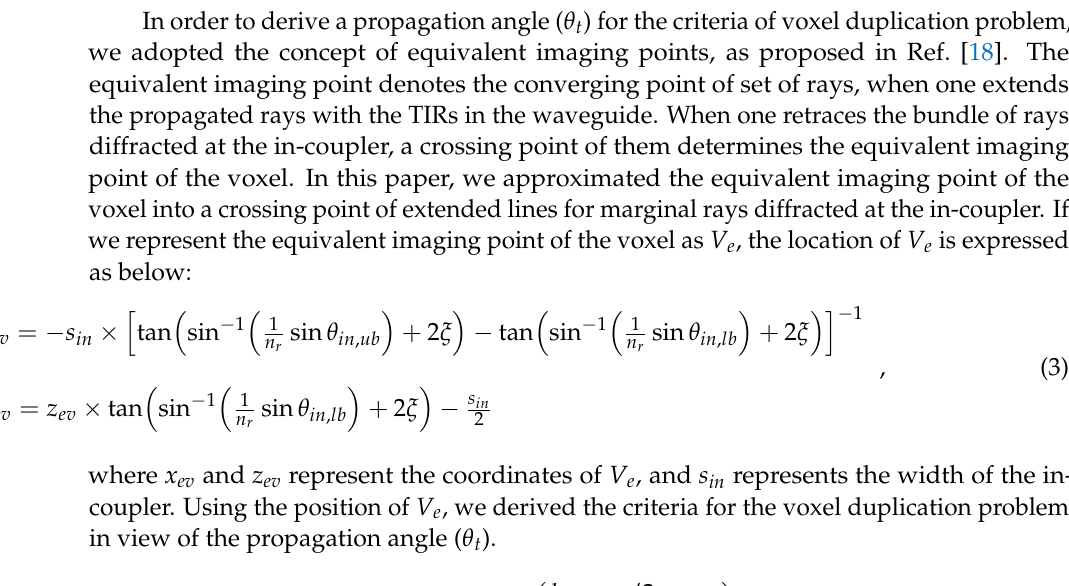
Figure 2. The trajectory of propagated rays by TIRs, which originate from the voxel V , in the holographic waveguide. We illustrate the virtual waveguide models as being stacked up for the intuitive investigation of ray trajectory according to the multiple TIRs.